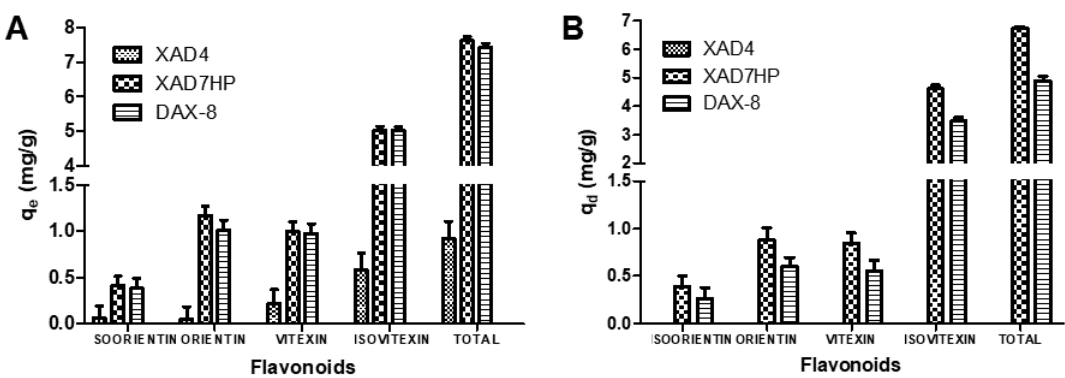
Figure 2. Adsorption ( A ) and desorption ( B ) capacities of three different macroporous resins (MARs) for major flavonoid C -glycosides in acid-hydrolized oil palm leaves (OPLAH). Each value is the average reading from three replicates (n = 3).